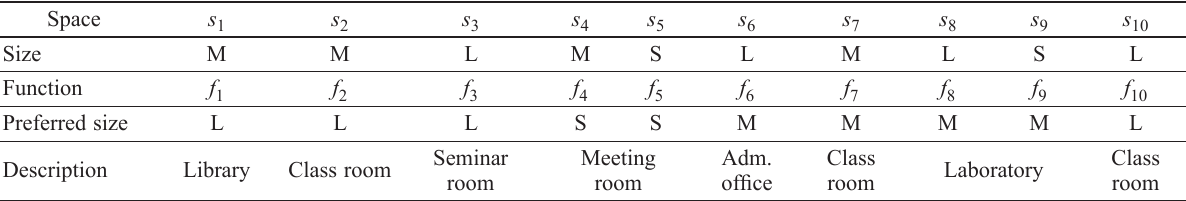
Fig. 7. Comparison of Architect’s function assignment and the assignment result R 2 (Objective value = 1.10471 vs. Objective value = 1.25849) Table 1. Space size and functions’ preferred size Space s